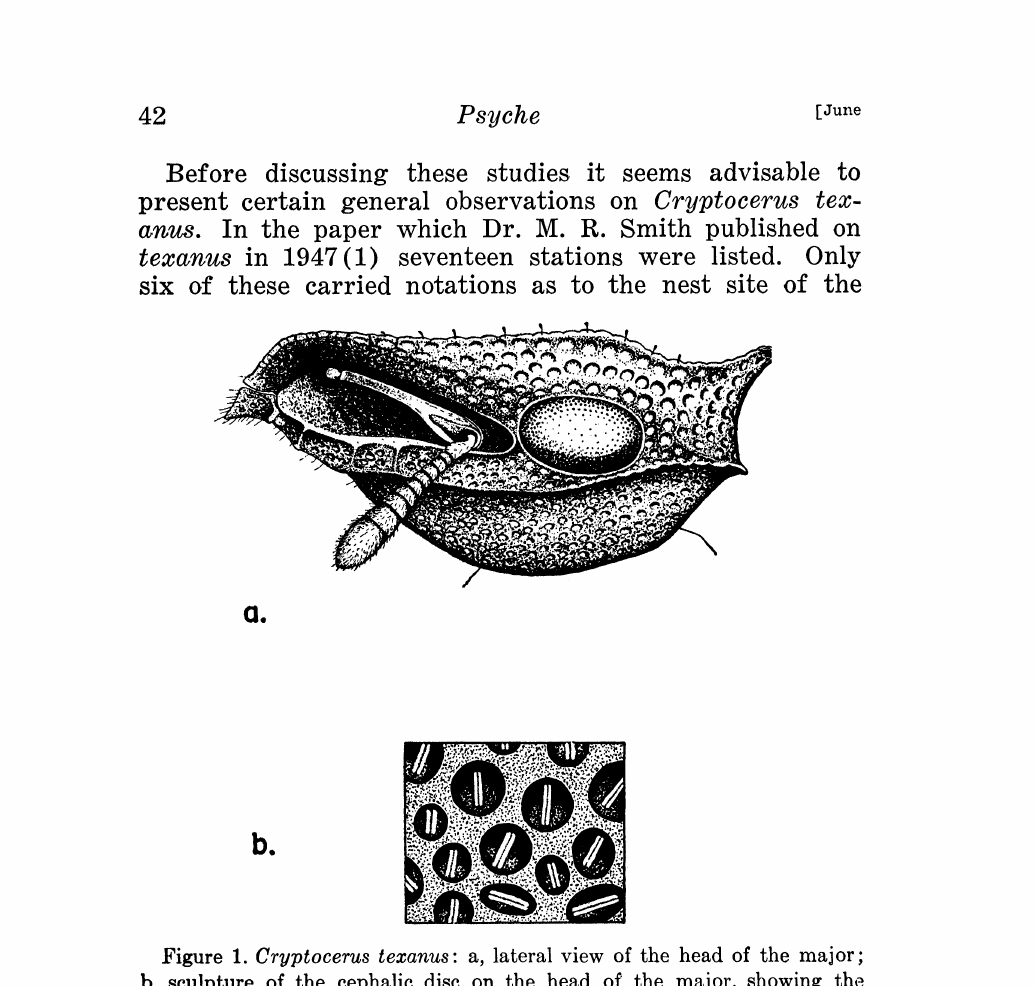
Figure 1. Cryptocerus texanus: a, lateral view of the head of the major; b, sculpture of the cephalic disc on the head of the major, showing the rectangular, silvery, longitudinally grooved hair in each foveola. Figure 1, a, is drawn to a scale twice that of plates 3 and